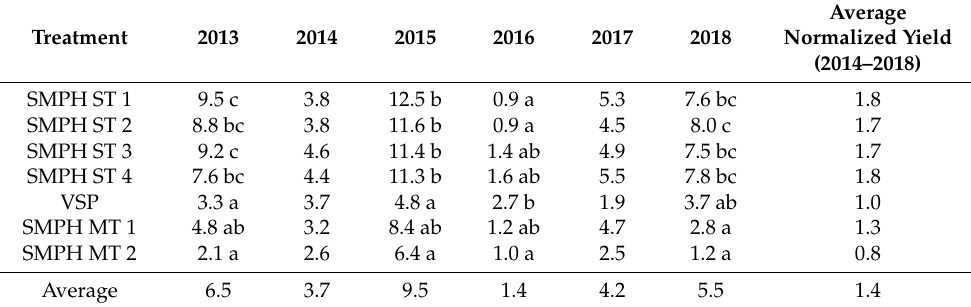
Table 4. Average values of the yield (kg/plant) between 2013 and 2018 as well as average normalized yield values for 2014–2018 (value of the yield of the respective treatment in a specific year/value of the standard treatment, VSP, in that year). Yield values of different treatments in the same year marked with the same letter did not differ significantly (according to Tukey’s multiple comparison procedure ( p ≤ 0.05)). Average (2014–2018) normalized yield values are depicted. If no letter codes are indicated, differences were non-significant.